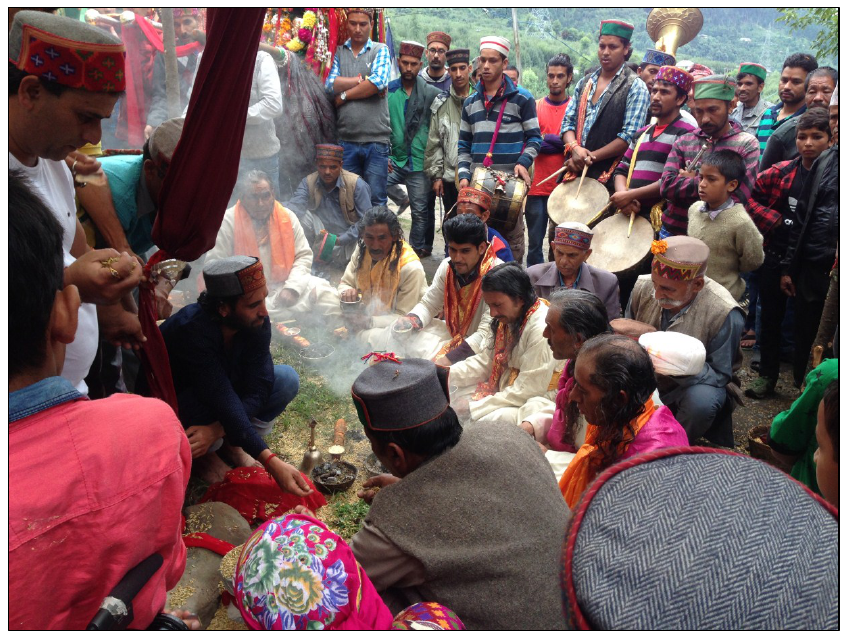
Figure 5. Final Round of Chidra Yajna. The mediums sit below the Nar, the deities chariots ( raths ) and followers in the background.